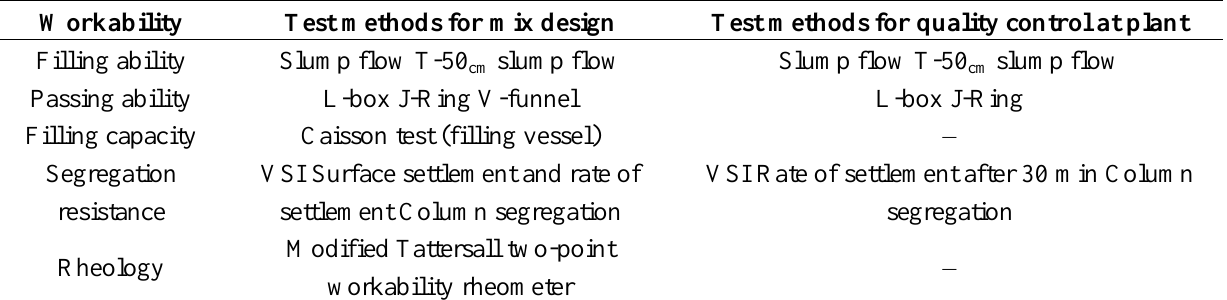
Table 1. Test methods relevant for fabrication of precast, prestressed structural